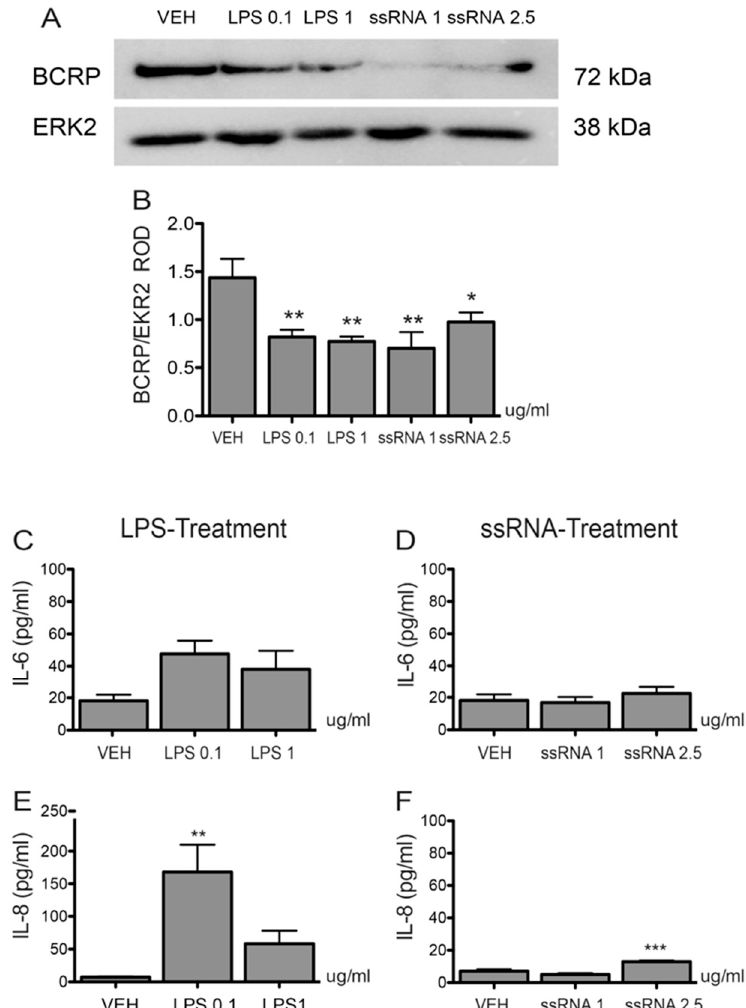
Figure 5. Effect of LPS and ssRNA on BCRP protein expression and IL-6 and IL-8 secretion in HTR8/Svneo cells. Cells were treated with LPS (0.1 or 1 µg/mL) or ssRNA (1 or 2.5 µg/mL) or their vehicle control (VEH) for 12 h. ( A ) Representative western blot for BCRP expression. ( B ) Densitometric analysis of BCRP expression normalized to ERK2. Secreted IL-6 ( C , D ) and IL-8 ( E , F ) protein levels were measured from HTR8/SVneo cell culture supernatants by enzyme-linked immunosorbent assay (ELISA) 12 h post treatment with 1 µg/mL LPS ( C , E ) or 2.5 µg/mL ssRNA ( D , F ) or with VEH. Data are expressed as means ± SEM, n = 6 experiments. Statistical differences were tested by one-way ANOVA followed by the Newman-Keuls post-hoc test. * p < 0.05, ** p < 0.01, *** p < 0.001 versus VEH.